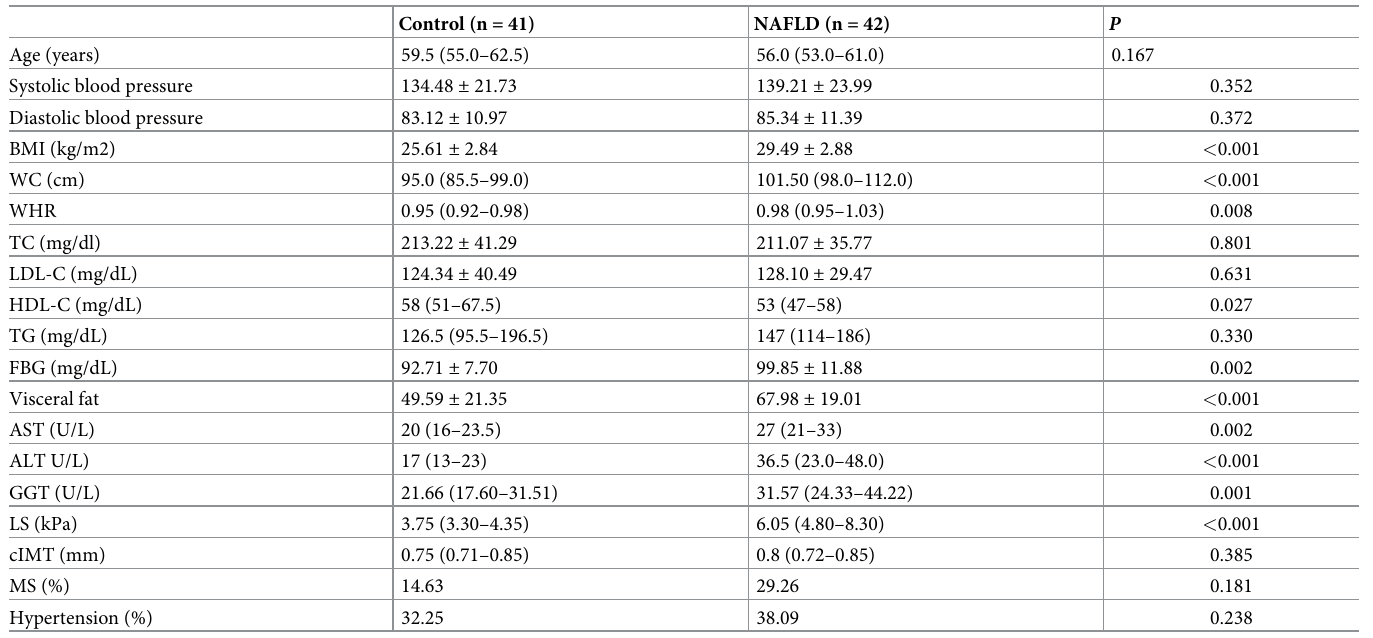
Table 1. Baseline characteristics among NAFLD patients and control subjects.